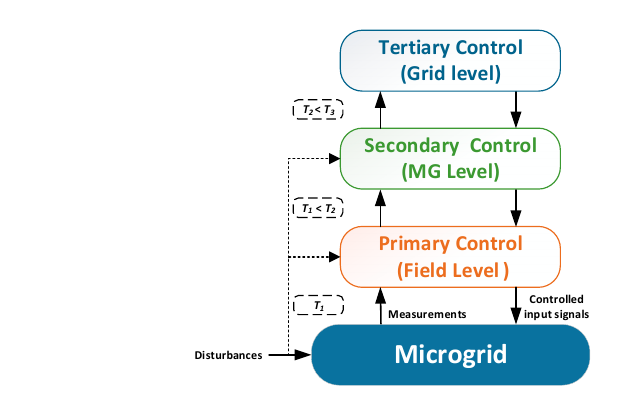
Figure 5. Various secondary control architectures: ( a ) distributed; ( b ) centralized; ( c ) decentralized.